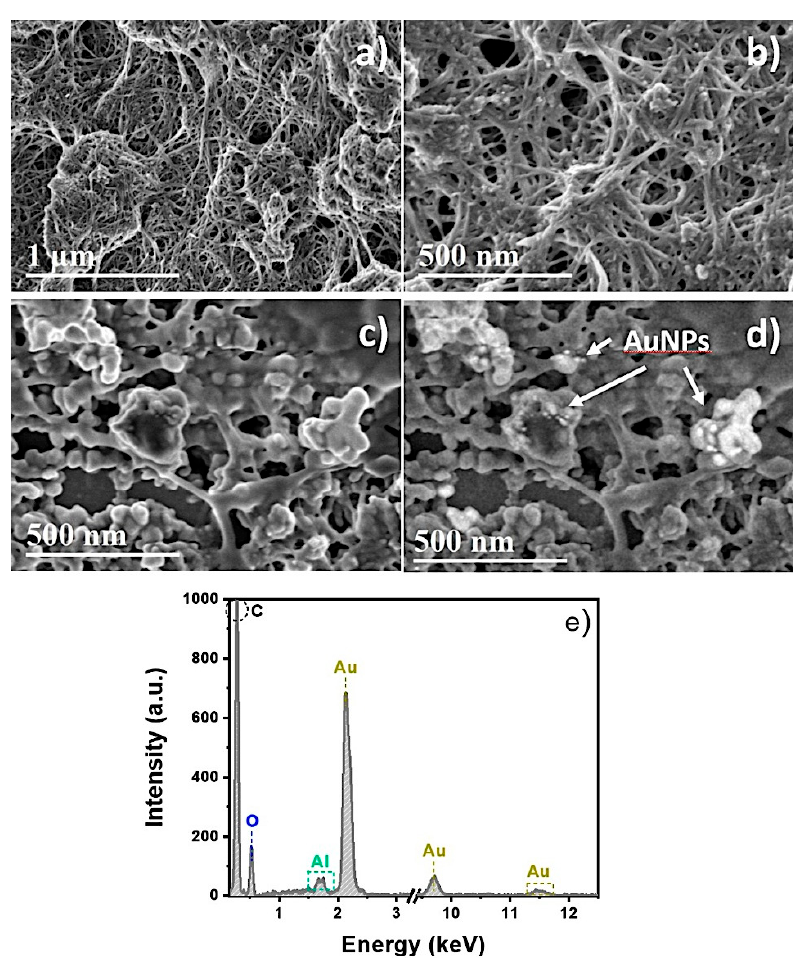
Figure 9. ( a , b ) SE-SEM images of commercial CNT-SPE, ( c , d ) SE-SEM images of the commercial Figure 9. ( a ) and ( b ) SE-SEM images of commercial CNT-SPE, ( c ) and ( d ) SE-SEM images of the CNT-SPE modified with AuNPs, and ( e ) EDS spectrum of commercial CNT-SPE and commercial CNT-SPE modified with AuNPs, and ( e ) EDS spectrum of commercial CNT-SPE and AuNPs.